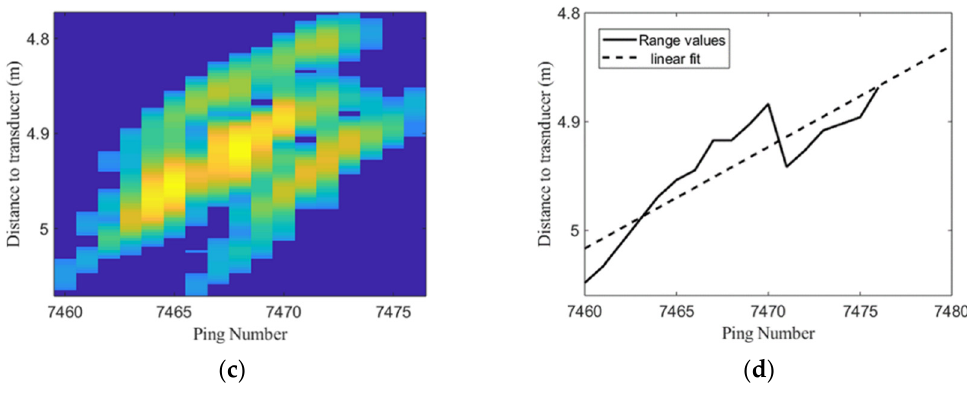
Figure 5. ( a ) Trace of fish with swimming tilt indicator (STI) = 0.07, ( b ) Range values and linear fit from trace in ( a ), ( c ) Trace of fish with STI = 0.53, ( d ) Range values and linear fit from trace in ( c ).